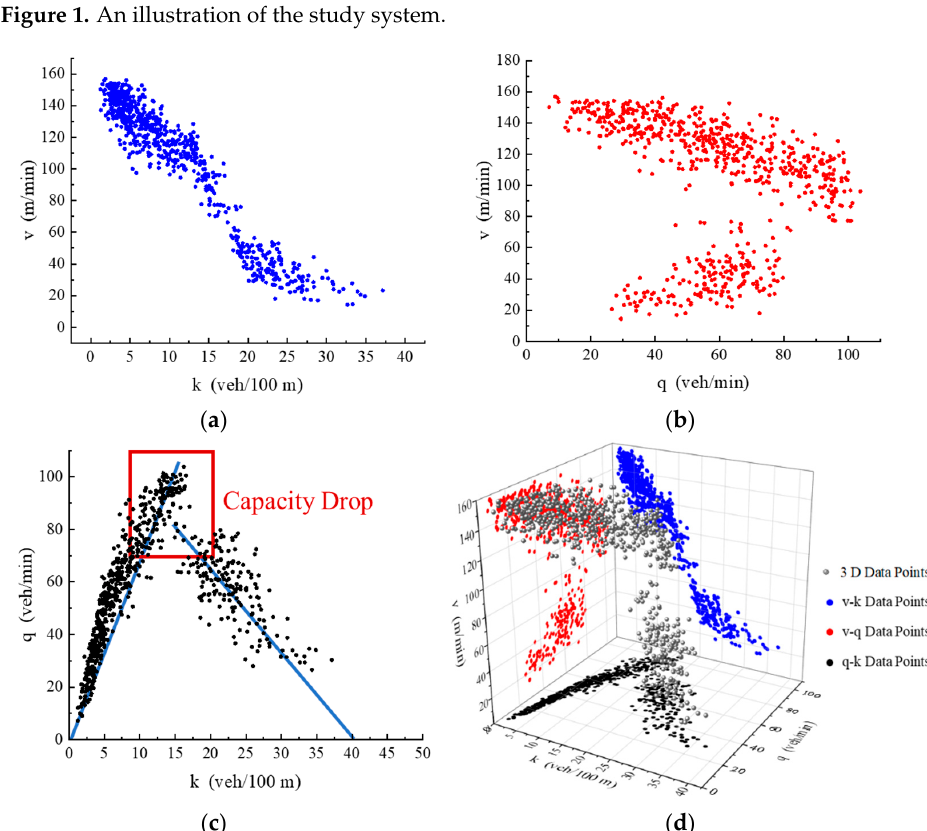
Figure 2. MFD from experimental data for departure vehicles at the airport: ( a ) V-K relationship; ( b ) V-Q relationship; ( c ) Q-K relationship; ( d ) Q-K-V